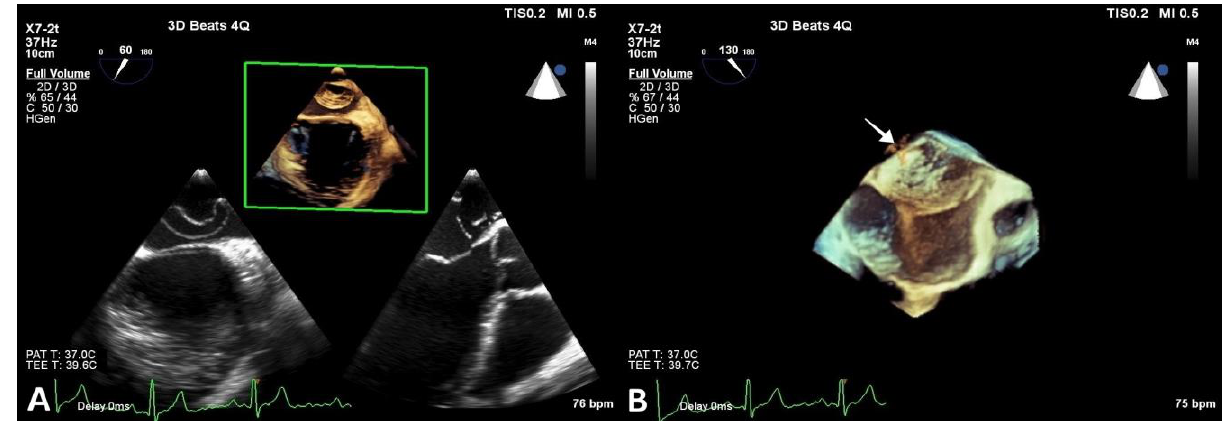
Figure 3. Transesophageal echocardiography revealing CTS. ( A ) and ( B ) show 2D and 3D reconstructions visualizing the membrane and its fenestrations (arrow).